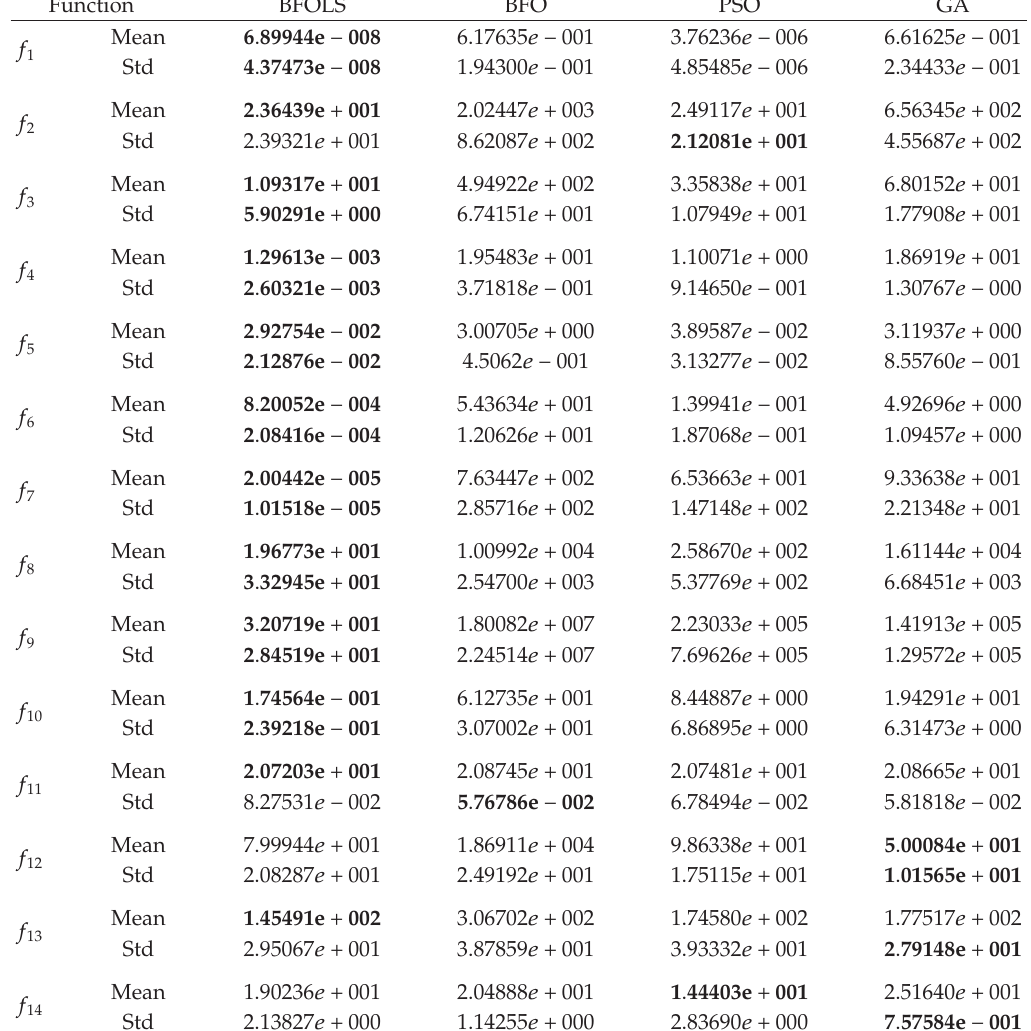
Table 3: Error values obtained by the BFOLS, BFO, PSO, and GA algorithms with dimension of 20.